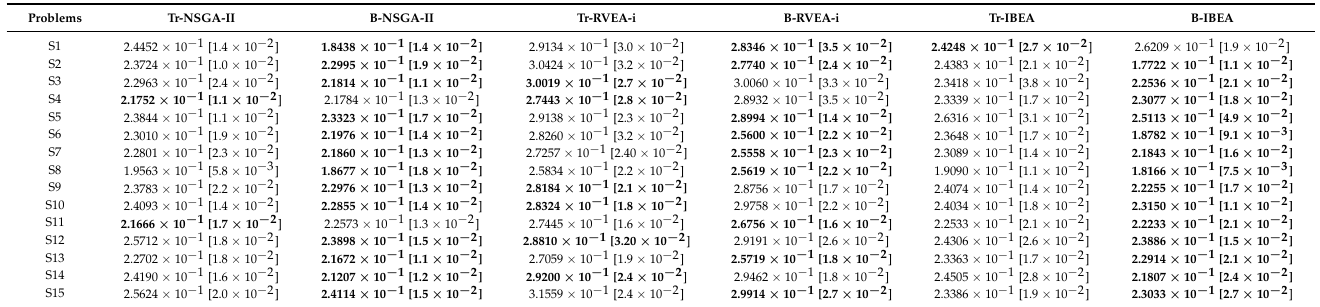
Table 6. Mean and standard deviation values of the MIGD metric obtained by comparing algorithms for small-scale instances.